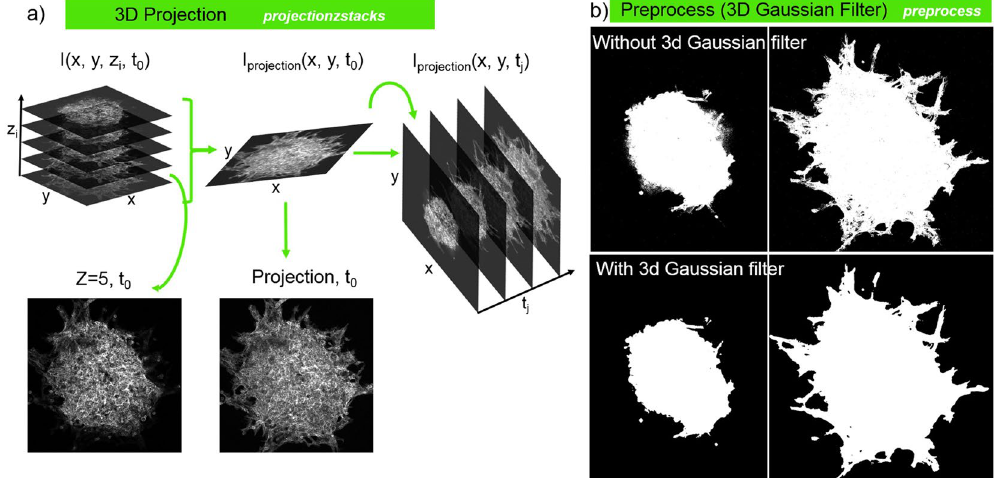
Figure 3. Contrast enhancement and smoothing. ( a ) 3-dimensional projection algorithm converting z stacks at each time point to projection image, and then using projection images at each time point for preprocess. ( b ) Segmentation effects comparison between without and with 3-dimensional Gaussian filter. 3-dimensional Gaussian filter smooth the segmentation in both spatial and temporal.